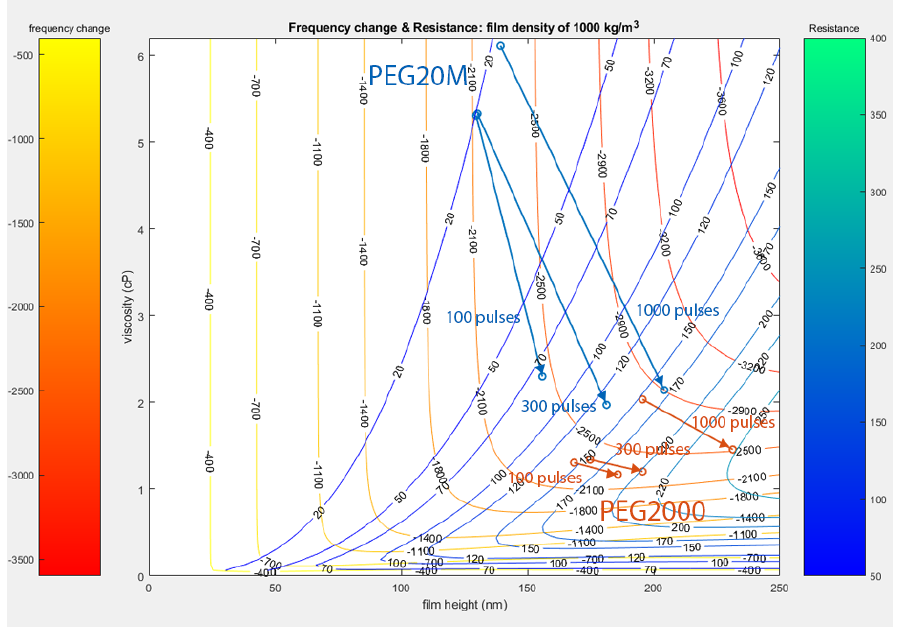
Figure 28. Combined contour plot of both resistance and frequency change when PEG films are exposed to water. The arrow line represents the frequency and resistance change of the coated QCM when exposed to 100, 300, and 1000 pulses of water; blue arrow: PEG20M, orange arrow: PEG2000. Reprinted from [76] under the Creative Commons CC BY 4.0 license.